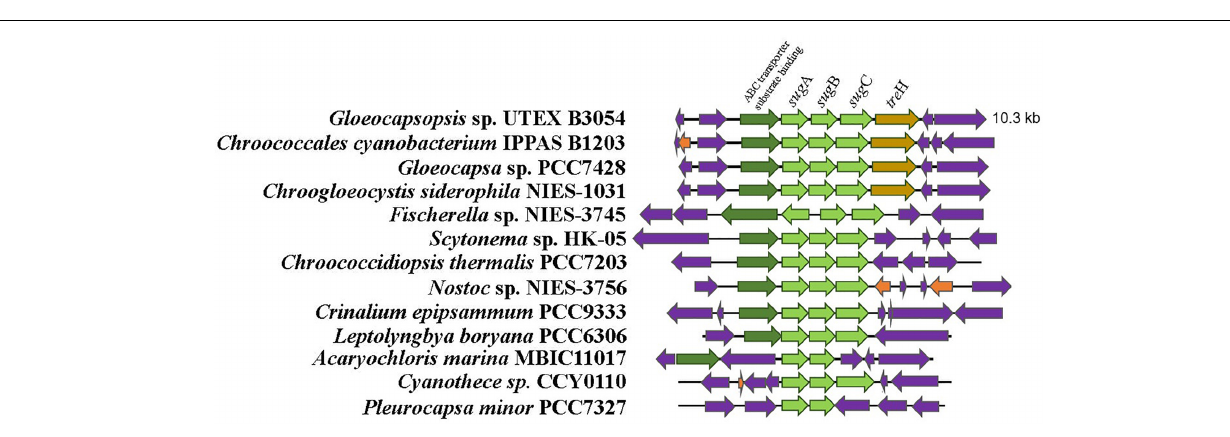
FIGURE 3 | Organization of the sug A– sug B– sug C locus in cyanobacteria. Maximum-likelihood tree was generated with IQTree Software based on the evolutionary substitution model LG + I + G4. Only cyanobacteria from Chroococcaceae family have the tre H flanking the 3 (cid:48) end of sug A– sug B– sug C genes. Note also that in this family an homoserine kinase and an ABC transport binding protein are located at the 5 (cid:48) end of this gene